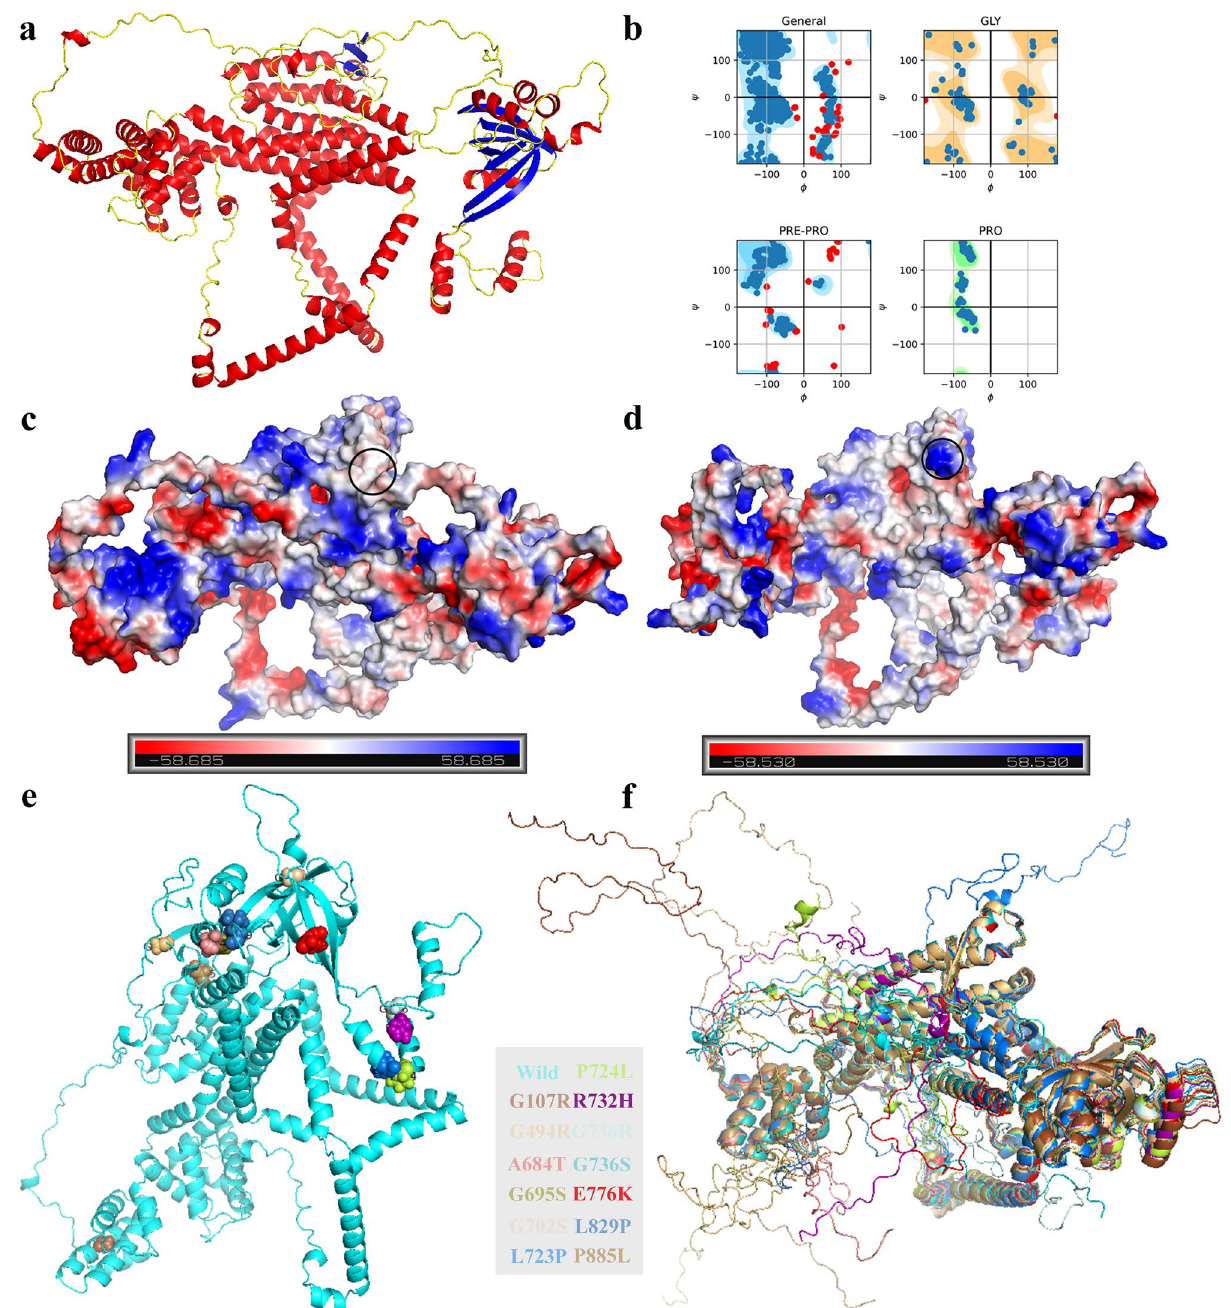
Figure 5. Protein structure predicted by the PyMOL. ( a ) The protein structure of the wild type wolframin (Red: alpha helix; Blue: beta sheet; Yellow: random coils and other structures). ( b ) A validation of 3D models by Ramachandran plot. ( c ) A qualitative electrostatic representation of wolframin protein generated by PyMOL. Protein contact potentials can be represented by displaying virtual (false) red/blue charged smooth surfaces on wolframin protein. ( d ) A qualitative electrostatic representation of mutant G494R protein generated by PyMOL. The black circle indicates the position of amino acid 494. ( e ) The wildtype protein model highlighting substitution regions. ( f ) Mutation-induced structural changes in WFS1. It shows superimposed view of wolframin protein in wild and mutant